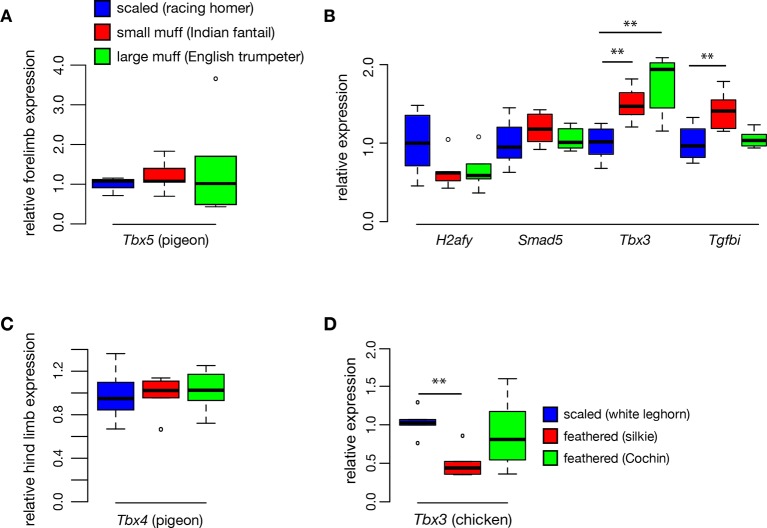
Quantitative RT-PCR expression analyses.(A) Expression levels of Tbx5 are similar among racing homer, Indian fantail, and English trumpeter HH25 forelimb buds (n = 6 samples each for all pigeon and chicken comparisons). (B) Expression comparisons for additional genes within candidate intervals on scaffolds 70 and 79. See main text for further discussion of Tbx3 results. (C) Expression levels of Tbx4 are similar among racing homer, Indian fantail, and English trumpeter hindlimbs. (D) Expression levels of Tbx3 are reduced in HH25 hindlimb buds of one (but not both) feather-footed chicken breeds.